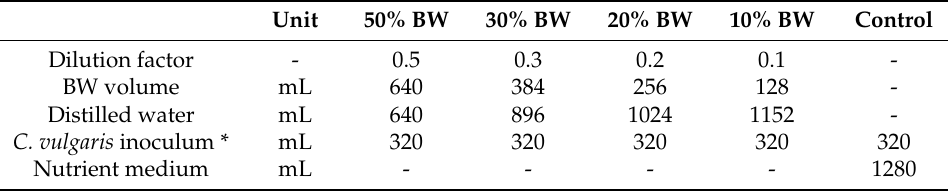
Table 1. Composition of the experimental mixtures in di ff erent blackwater (BW) dilutions. Unit